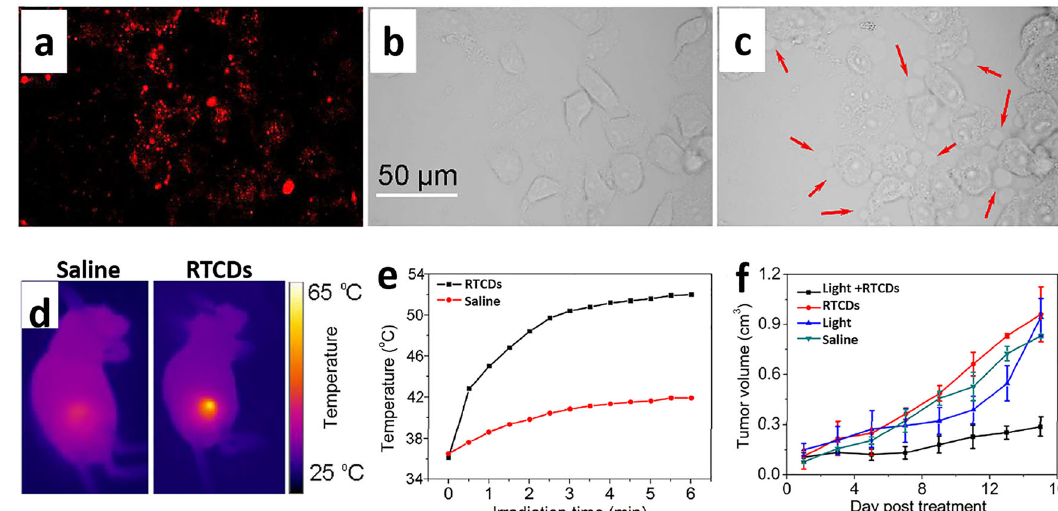
Fig. 7 RTCDs for in vitro and in vivo photothermal therapy. a Confocal fl uorescent microscopic images of RTCD-treated HeLa cells under 880 nm laser excitation. Transmission electron microscopic images of HeLa cells treated with RTCDs show the morphological changes b before laser irradiated and c after 3 min of 880 nm laser irradiation (red arrows point to blebs formed around the cells after laser irradiation). All images correspond to the same region. d IR thermal images of 4T1 tumor-bearing mice exposed to 880 nm laser for 6 min after saline injection (80 μ L) and RTCDs (1 mg mL − 1 , 80 μ L). e Time- dependent temperature changes of tumors injected with saline (red line with dots) or RTCD aqueous solution (black line dots) after 880 nm laser irradiation. f Time-dependent tumor volumes after different treatments with saline (green line with downward triangles), light (blue line with upward triangles), RTCDs (red line with dots), and light and RTCDs (black line with squares). (Fig. 7a – f adapted with permission from ref. 43 , Copyright 2017 Springer